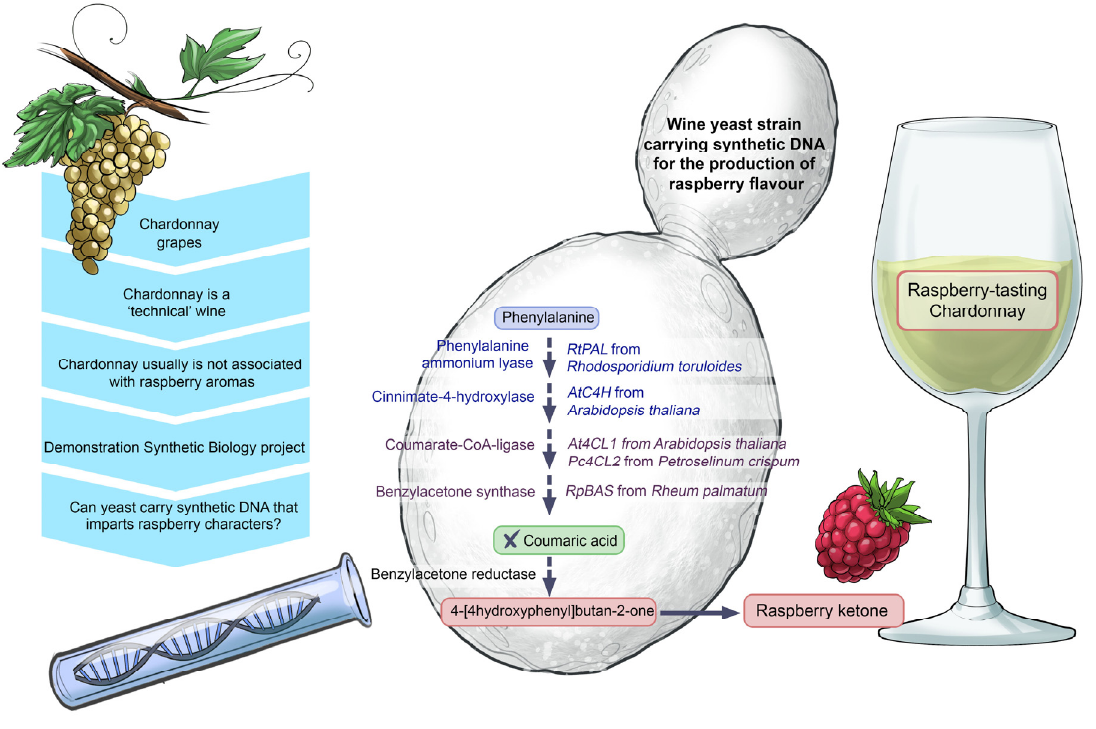
Figure 22. The construction of a ‘synthetic’ wine strain of Saccharomyces cerevisiae capable of producing raspberry aroma in Chardonnay (adapted from [24]). This is the first wine yeast containing a ‘synthetic DNA circuit’ coding for raspberry ketone formation.